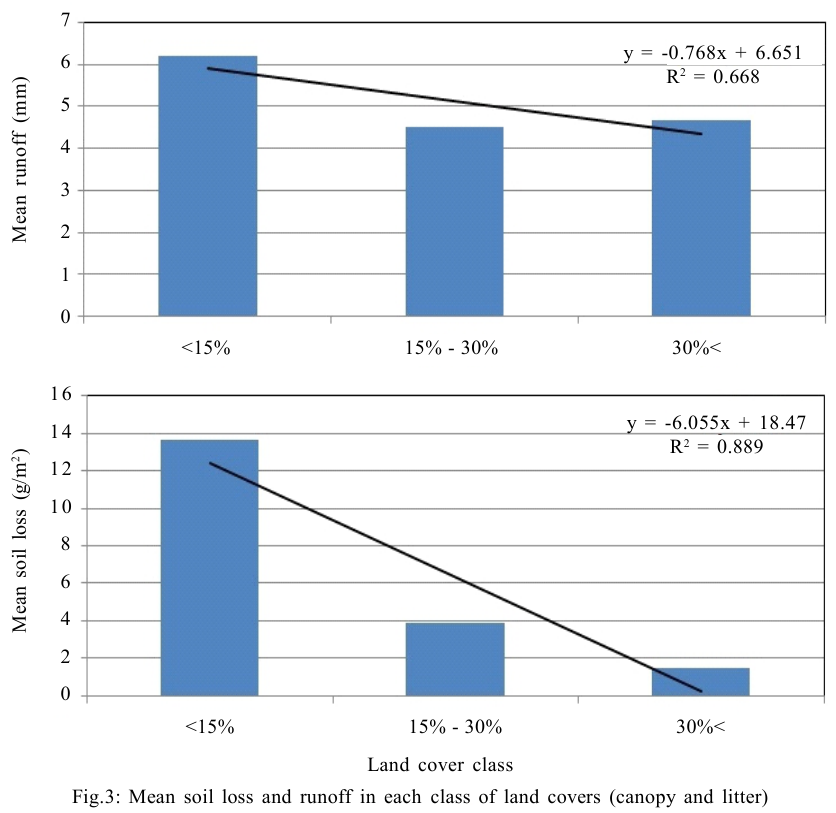
Land cover class Fig.3: Mean soil loss and runoff in each class of land covers (canopy and